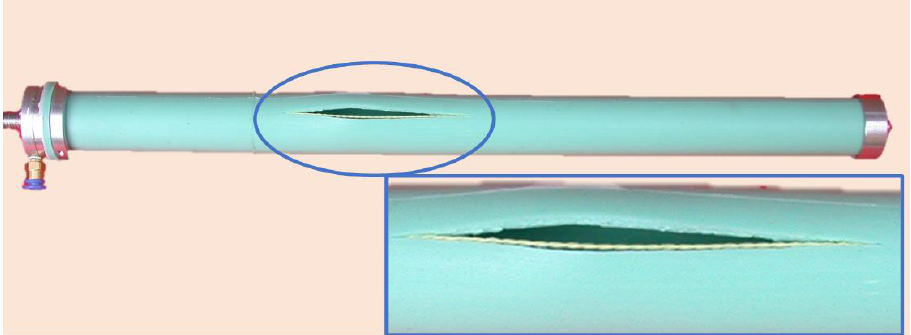
Figure 8. Typical rupture of a straight-fibers muscle in fatigue life duration tests.